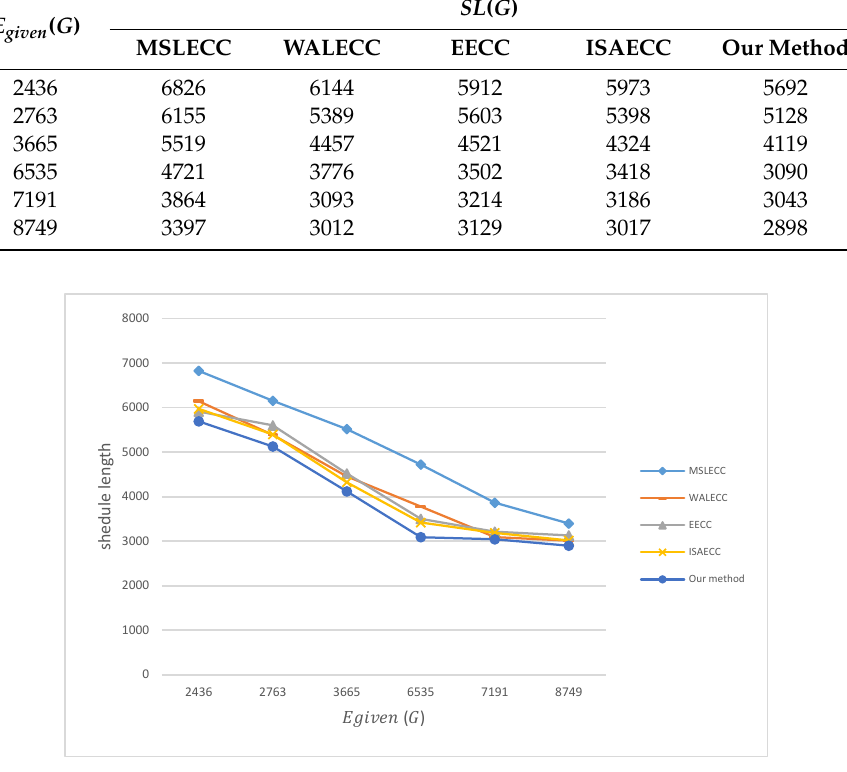
Figure 6. Final schedule length of GE application varying 𝐸 𝑔𝑖𝑣𝑒𝑛 (𝐺) .